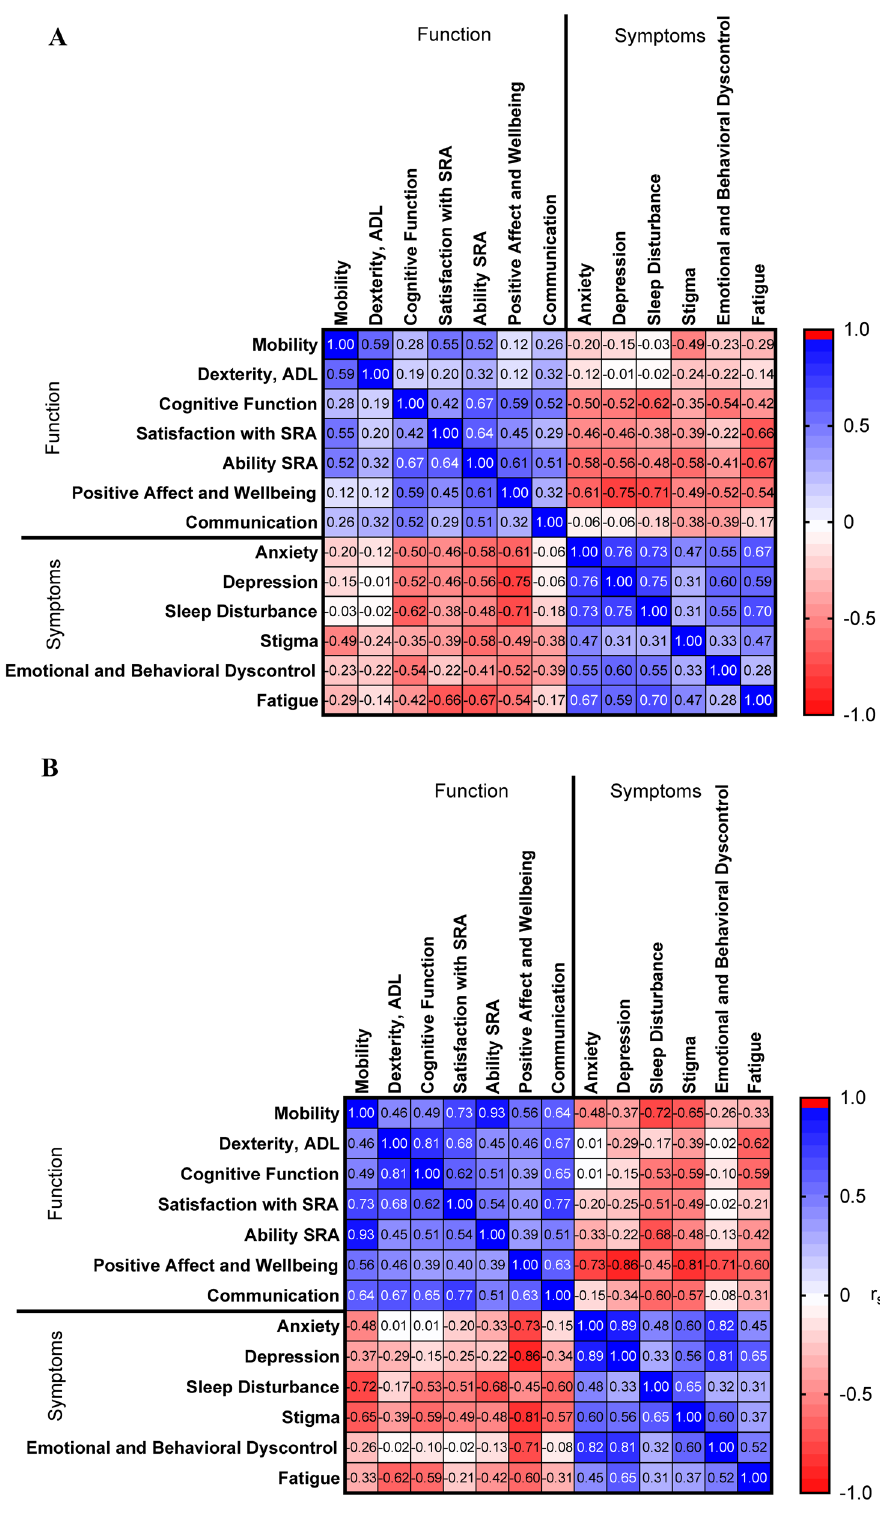
Figure 2. Correlation matrices of Neuro-QoL Domain T-scores for ( A ) CNS subjects (n = 36) and ( B ) non-CNS subjects (n = 10). r s = Spearman correlation